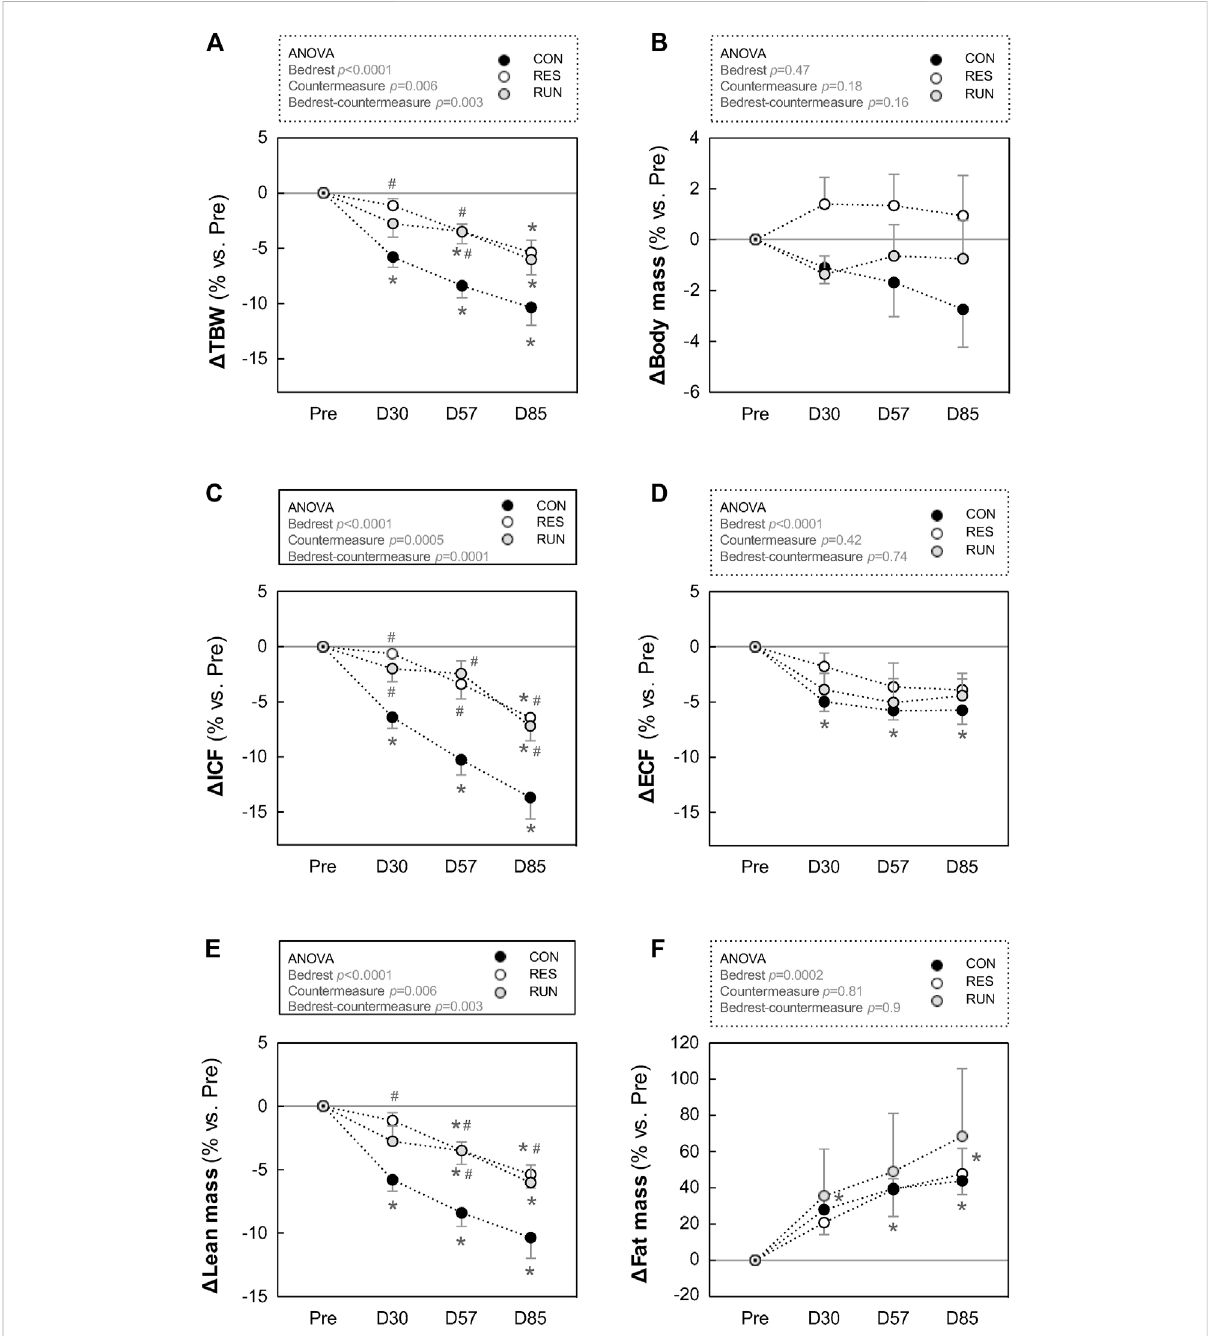
FIGURE 8 AveragedayandnightR-Rinterval (A,B) ,systolic bloodpressure (C,D) ,and physical activity (E,F) .To calculatemean “ day ” and “ night ” values,23: 00 – 05:00 was considered “ night, ” and 07:00 – 17:00 was considered “ day. ” The 22:00 and 06:00 points were excluded from the averages to avoid artifacts during these transition periods. Recordings were performed before HDBR and at the end of each month (M1, M2, and M3). The sample size was n = 8/CON. Data are presented as the mean ± SEM. * p < 0.05 vs.